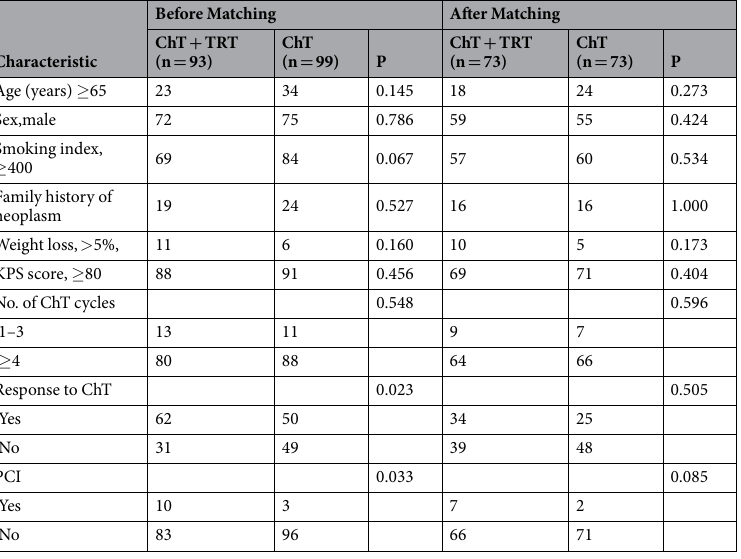
Table 4. Disease characteristics of patients with polymetastases with chemotherapy + thoracic radiotherapy vs. chemotherapy after Propensity Score